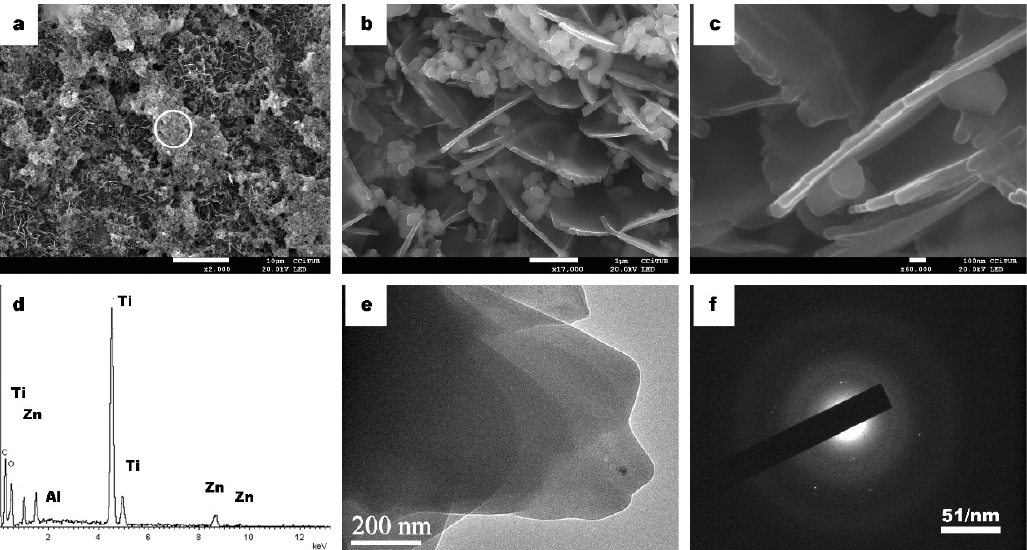
Figure 1. FESEM images of the superhydrophobic coating after 900 s of the electrodeposition -electrophoresis process at different magnifications showing ( a ) TiO 2 particles accumulated at the top of the flower-like structure, ( b ) TiO 2 particles and intercalation between the petals, and ( c ) the corresponding nanostructured petal. ( d ) EDS analysis of the flower-like structure, ( e ) an HRTEM micrograph of the petals from the flower-like structure, and ( f ) the SAED pattern showing weak rings from the petal.